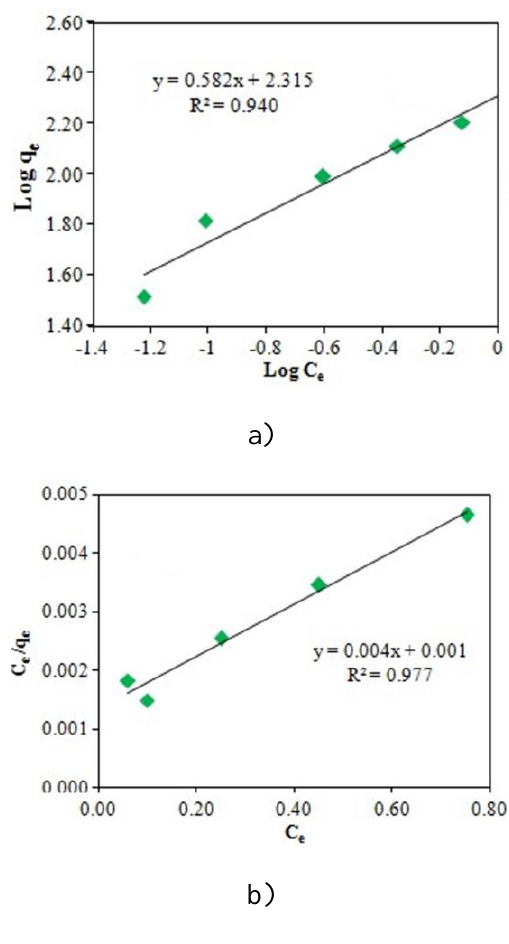
Figure 6. Freundlich (a) and Langmuir (b) isotherm plot for the adsorption of various concentrations of trinitrophenol (TNP) from solution onto PANI-TWC Table 2. Results of isotherm models for the adsorption of trinitrophenol (TNP) from solution onto